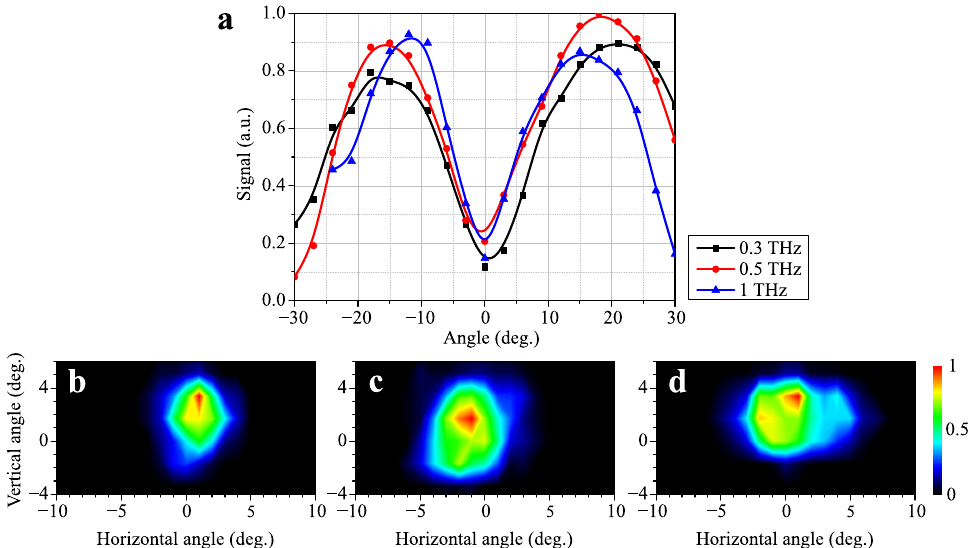
Figure 3. Normalized angular distribution of terahertz radiation without the pipe ( a ) and with the use of the polypropylene pipe for frequencies: 0.3 THz ( b ), 0.5 THz ( c ) and 1 THz ( d ). The focal length is 20 cm, laser pulse energy is 10 mJ.